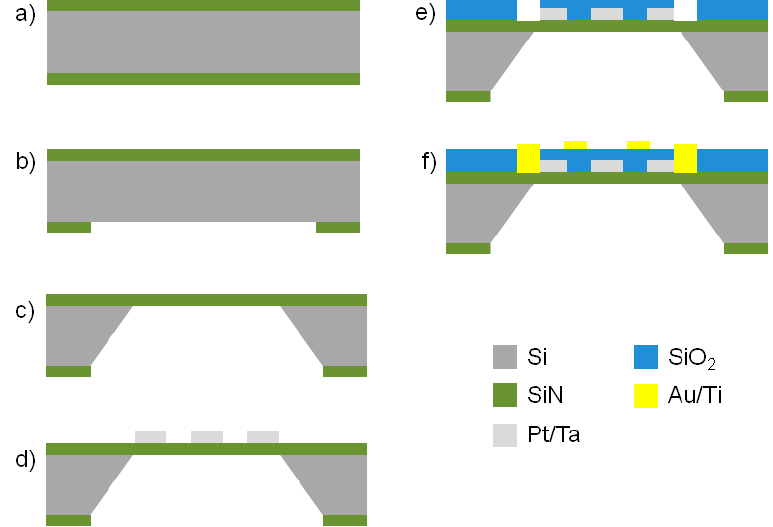
Figure 5. Process flow of the micro-hotplate fabricated according to the buried approach. ( a ) Si wafer terminated with low stress SiN (2 μ m thick) on both sides; ( b ) RIE of the SiN on the wafer backside; ( c ) KOH wet etching of the Si on the wafer backside; ( d ) patterning of the sputtered Ta (20 nm)/Pt (100 nm) resistor using aqua regia wet etching; ( e ) patterning of CVD grown SiO 2 through buffered oxide etch wet etching; ( f ) patterning of the Ti (20 nm)/Au (200 nm) contact pads and electrodes using lift-off. SiO 2 was chosen to bury the resistor and ensure the electrical insulation with respect to the